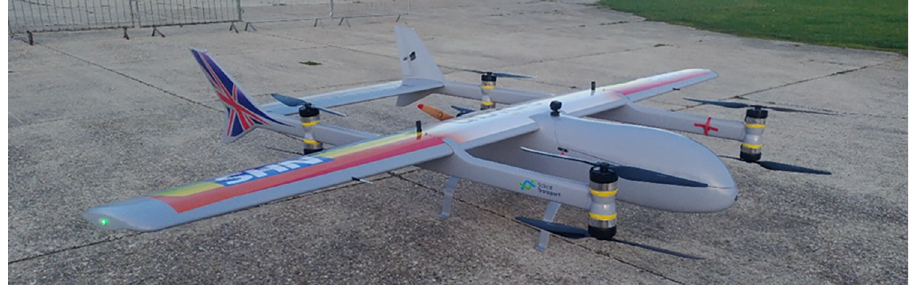
Fig 2. A render of a Mugin-5 Pro, 5m wing-span VTOL fixed-wing UAV, with a human for scale.